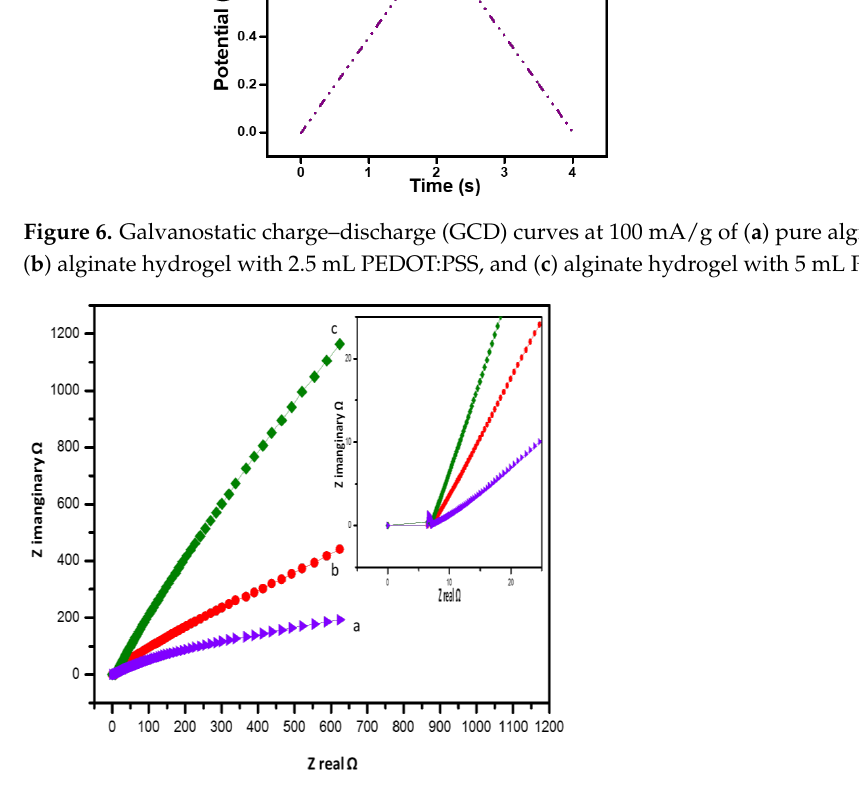
Figure 7. Nyquist plots of the ( a ) pure and ( b , c ) A/P:P composite hydrogel electrolytes.